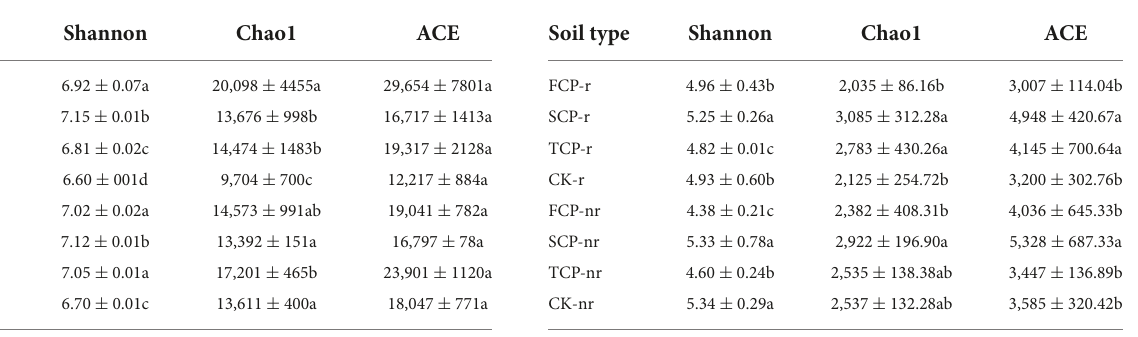
TABLE 3 Alpha diversity indices of soil fungi in different successive planting